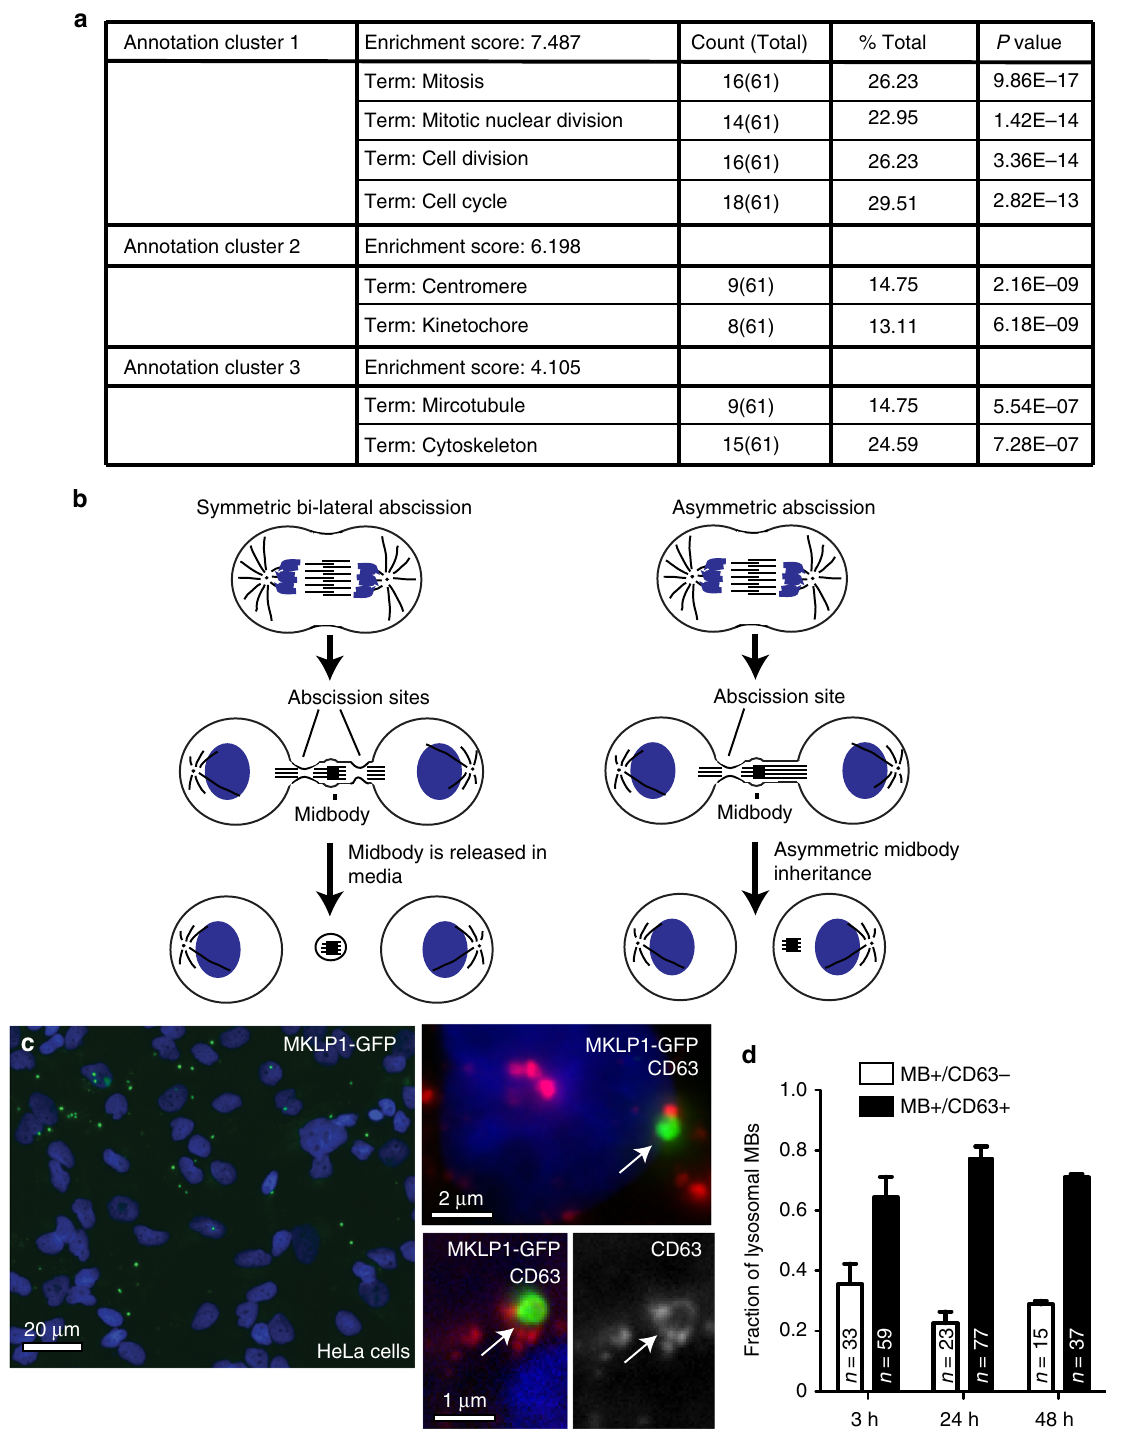
Fig. 1 Post-abscission MBs are internalized and accumulate in interphase cells. a DAVID functional cluster analysis of mRNAs up-regulated in GFP-MB + cells. P -value is represented by modi fi ed Fisher exact P -value. b Schematic representation of asymmetric and symmetric cell abscission. c, d HeLa cells were incubated with puri fi ed GFP-MBs for 3 h. Cells were then washed and incubated for additional 3 h before fi xation and staining with anti-CD63 antibodies. In c arrow in top inset shows MB that does not colocalize with CD63, while arrow in bottom insets shows MB that is surrounded by CD63- positive membrane. Panel d shows quanti fi cation of the colocalization between GFP-MBs and CD63. n is the number of internalized MBs counted for each condition. Three biological replicates were used to obtain